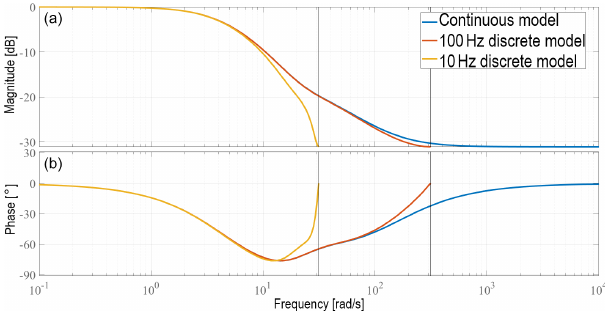
Figure 5. Bode diagram of the sensor model. Magnitude and phase are shown in panels (a) and (b) ,